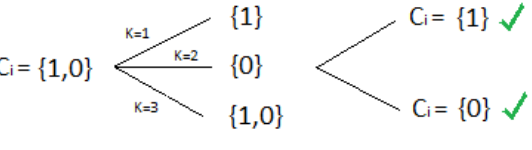
Figure 4: Instance with imprecise output that is not